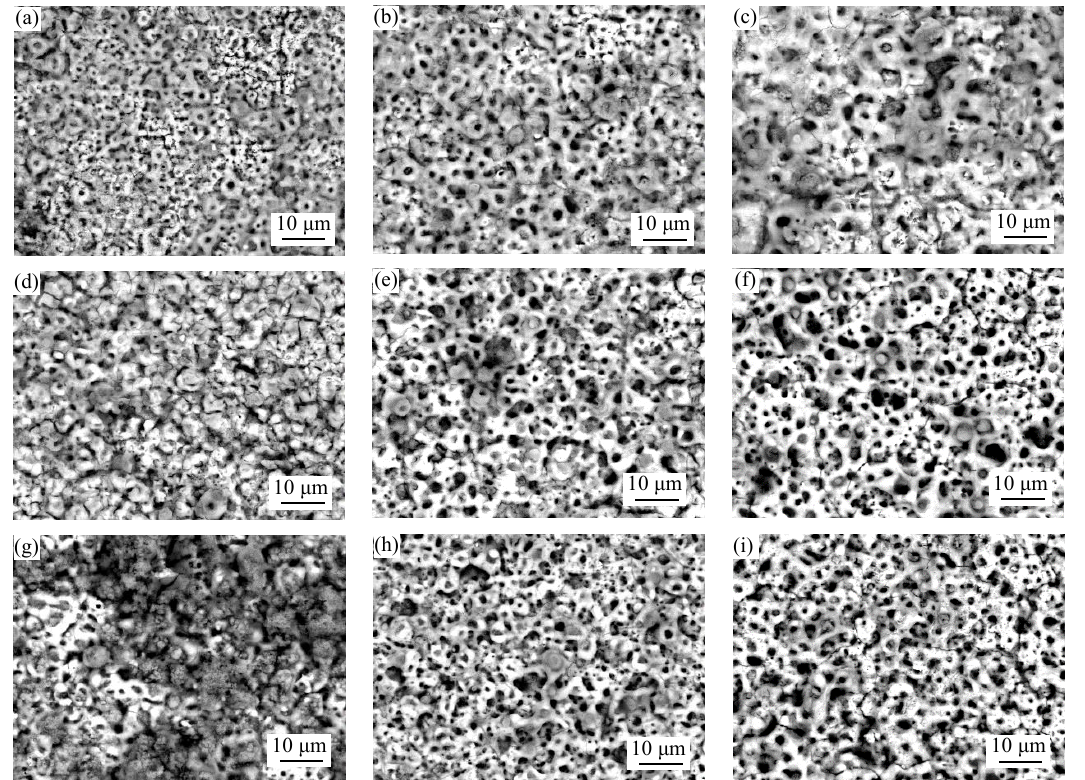
Figure 2. Surface morphology of coatings obtained based on orthogonal experiment: ( a – i ) are 1 # – 9 # respectively. With the change of concentration, voltage and treating time, the coating morphologies have been to some extent modified and the changing of surface roughness and porosity can be observed from Figure 3. According to Figures 2 and 3, the MAO coatings which with the content of 6 g/L (NH 4 ) 2 ZrF 6 have the lowest roughness. In addition, the porosity keeps increasing with the increase of (NH 4 ) 2 ZrF 6 and reaching the maximum at 9 g/L. This may be because there was strong spark discharge at low voltage due to the excessively high concentration of zirconium, which increase surface roughness and porosity.